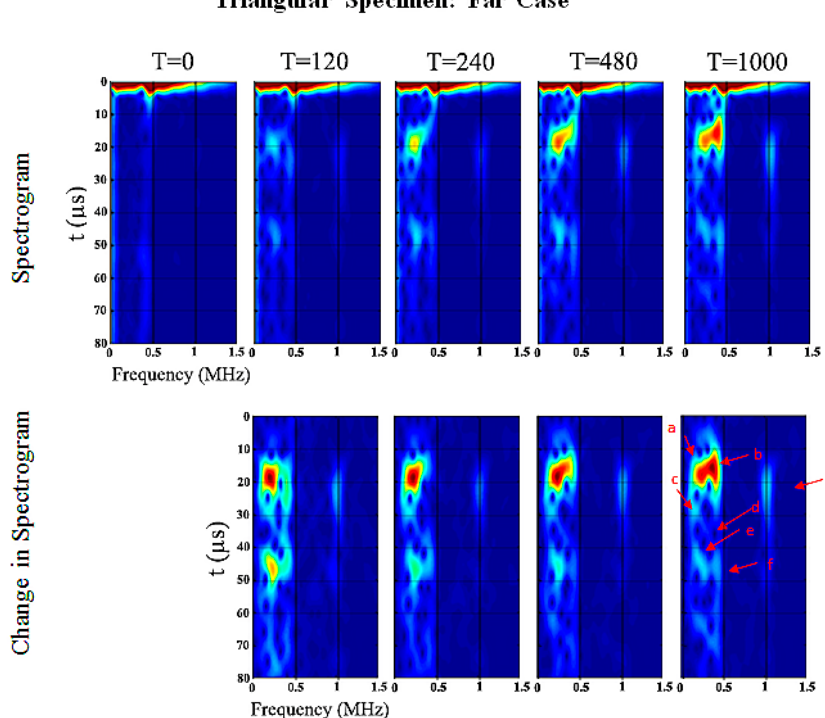
Figure 13. Triangular specimen (Far): Spectrogram and changes in spectrogram for each cure time relative to the baseline.